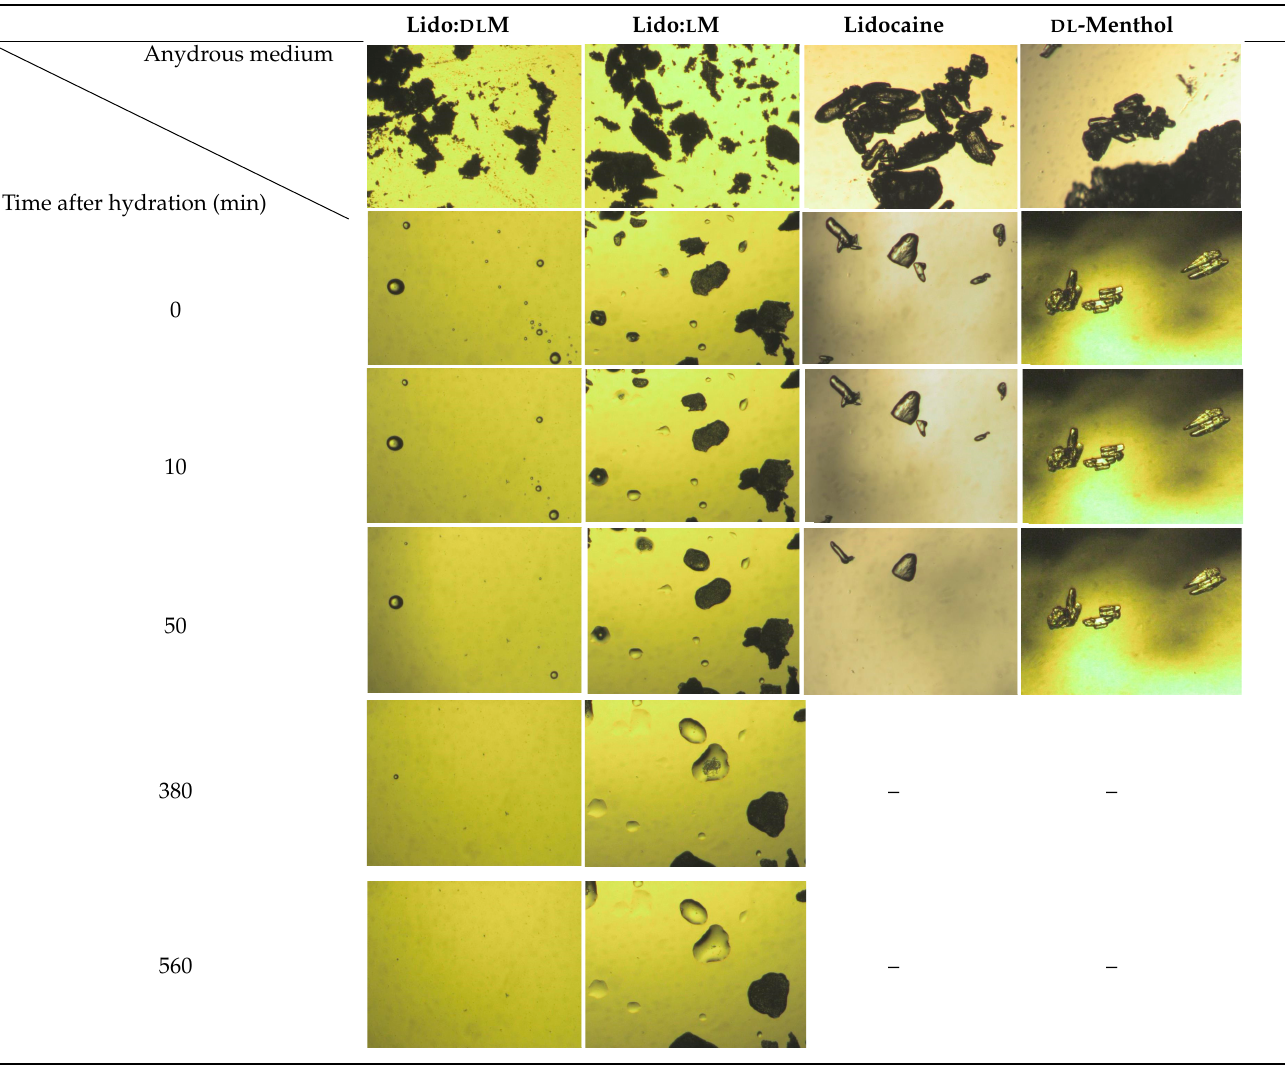
Table 6. Images illustrating the kinetics of dissolution of the lidocaine: L -menthol and lidocaine: DL - menthol cocrystals (7.2 mg.mL − 1 ) compared with the pure constituents, i.e., lidocaine (4.3 mg.mL − 1 ), and DL -menthol (2.9 mg.mL − 1 ) at 25 °C. Width of each image: 4 cm.